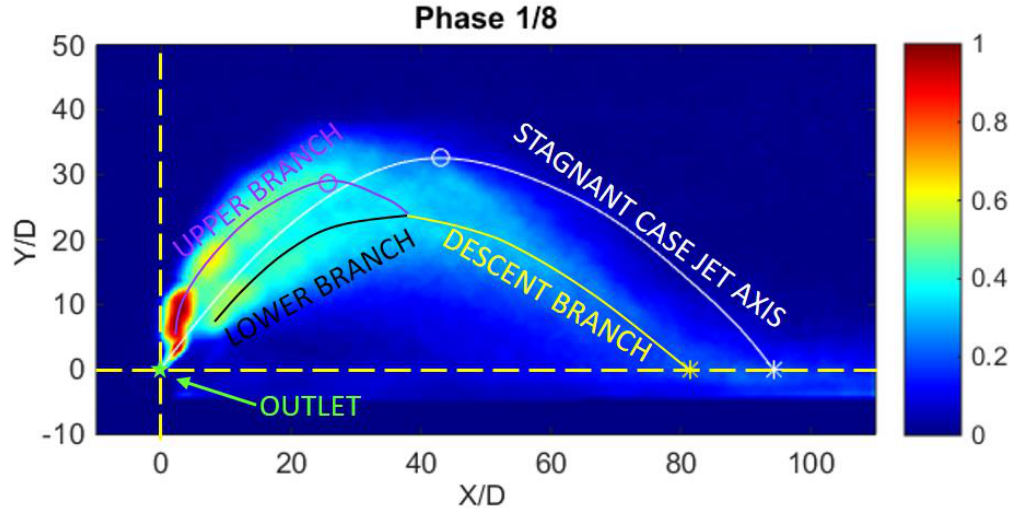
Figure 5. Non-dimensional mean concentration fields for the same NBJ of Figure 3, in phase 1/8, with the jet geometrical features; the maximum uncertainty in the mean concentration measurement is ±4.38%.